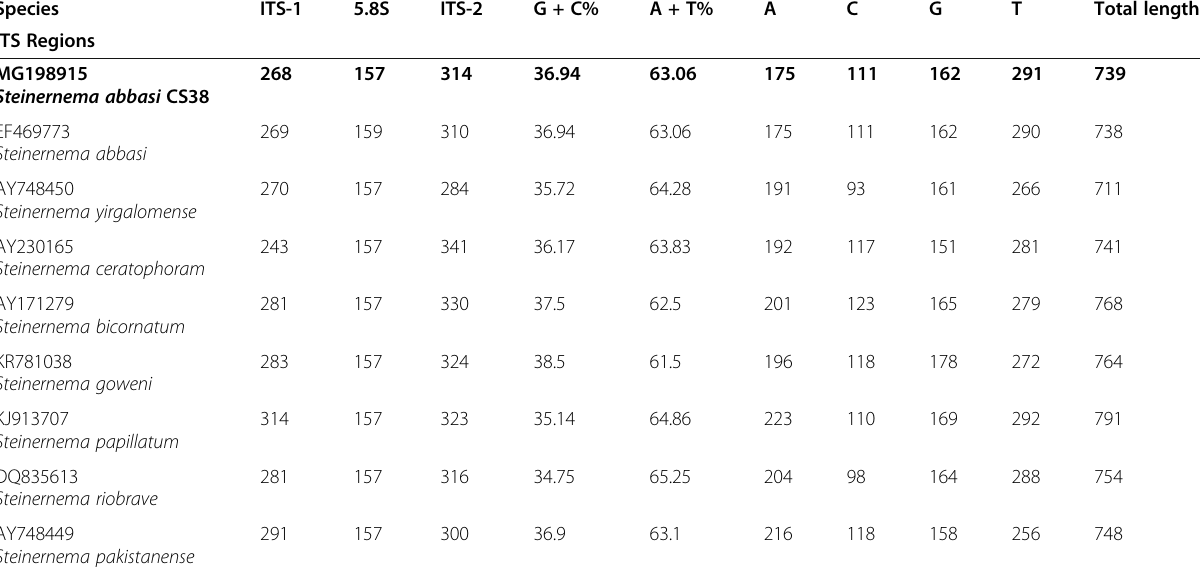
Table 3 Nucleotide composition of Steinernema abbasi isolate CS38 compared with the other known species based on Internal Transcribed Spacers (ITS) region Species